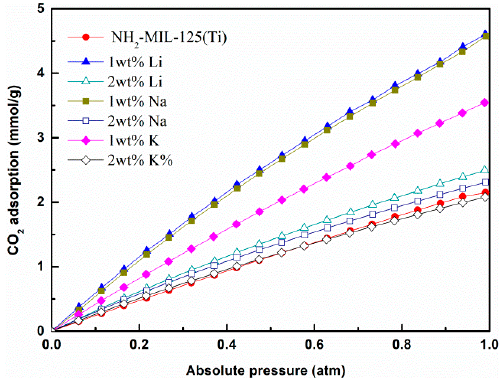
Figure 8. CO 2 adsorption isotherms of NH 2 –MIL125(Ti) and x M@NH 2 –MIL125(Ti) at 293 K. Table 2. Comparison of CO 2 adsorption on reported metal–organic frameworks (MOFs).